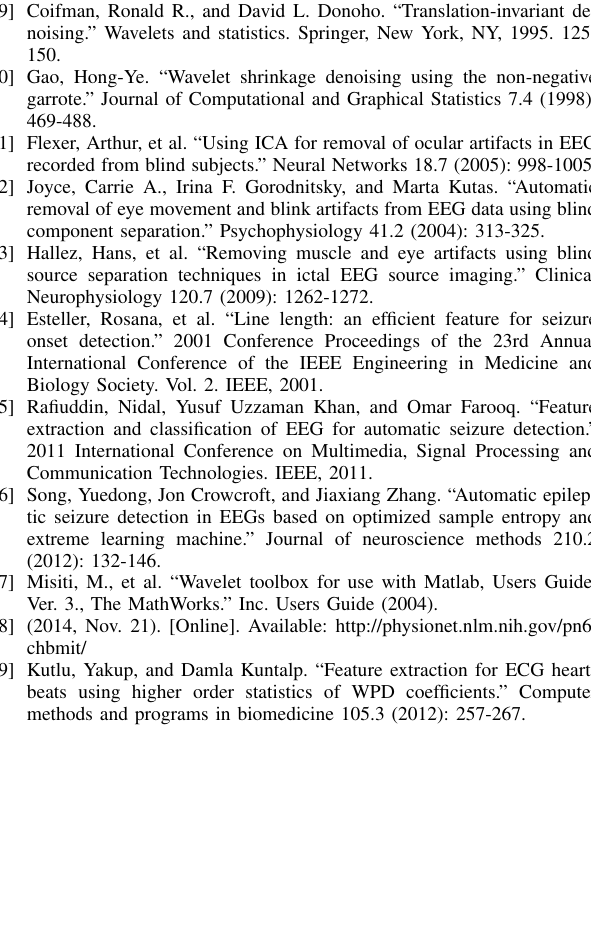
Fig. 5. Original Data, Artifact Removed Data and Artifact Data